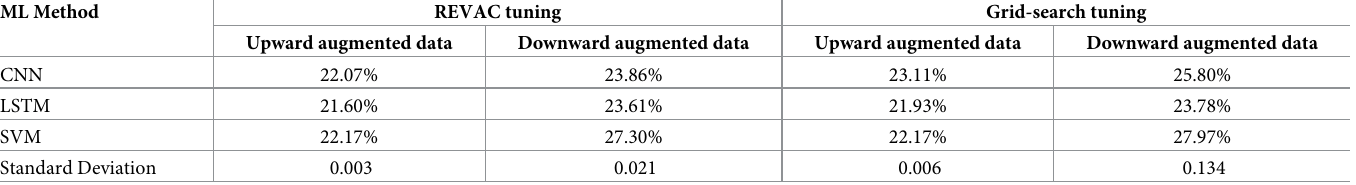
Table 4. RMSE averages for REVAC and grid-search method parameter